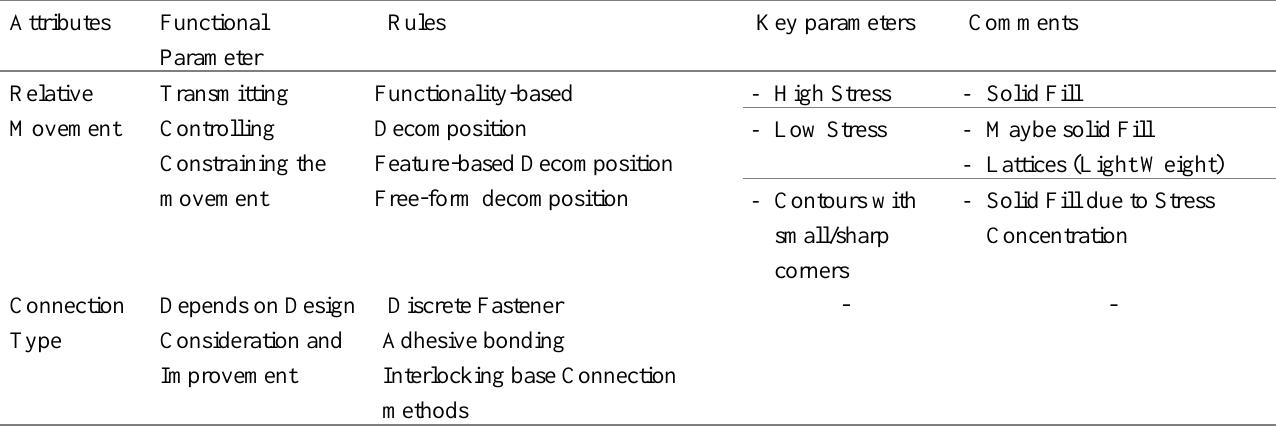
Effects of functional Parameters